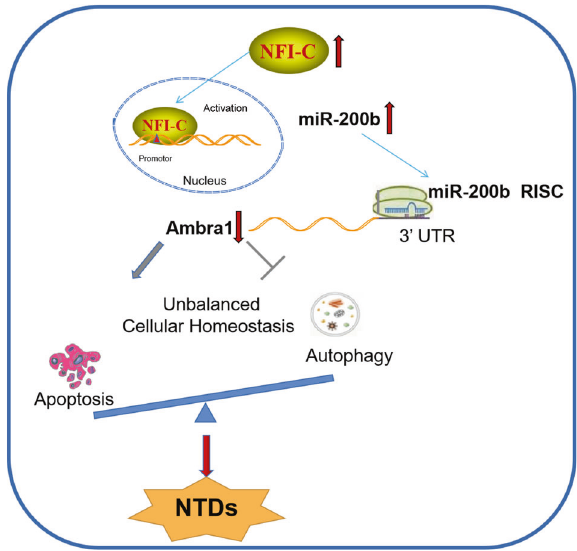
Fig. 6 Role of NFIC-miR-200b-Ambra1 pathway in modulating autophagy and apoptosis in NTDs. A schematic diagram depicting the overexpression of NFIC-enhanced miR-200b transcriptional activity, followed by the suppressed translation of Ambra1, which is the downstream target of miR-200b, leading to impaired autophagy/excessive apoptosis and the subsequent formation of